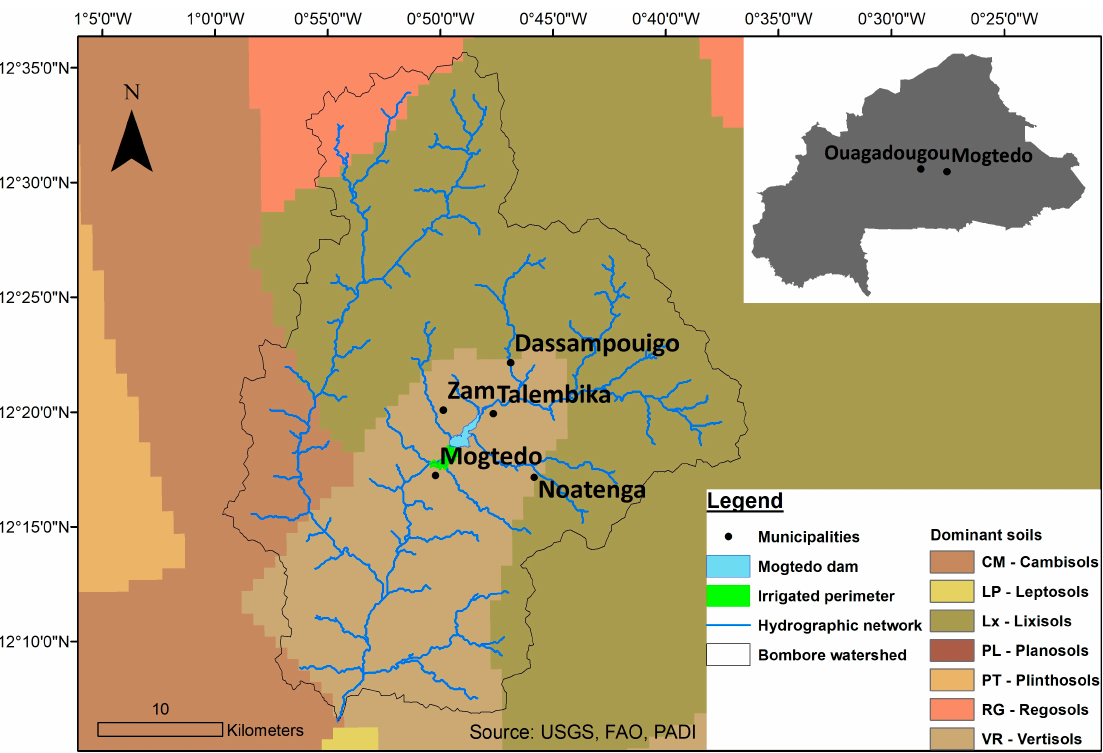
Figure 1. Map showing the Mogtedo water reservoir along with the surrounding municipalities.